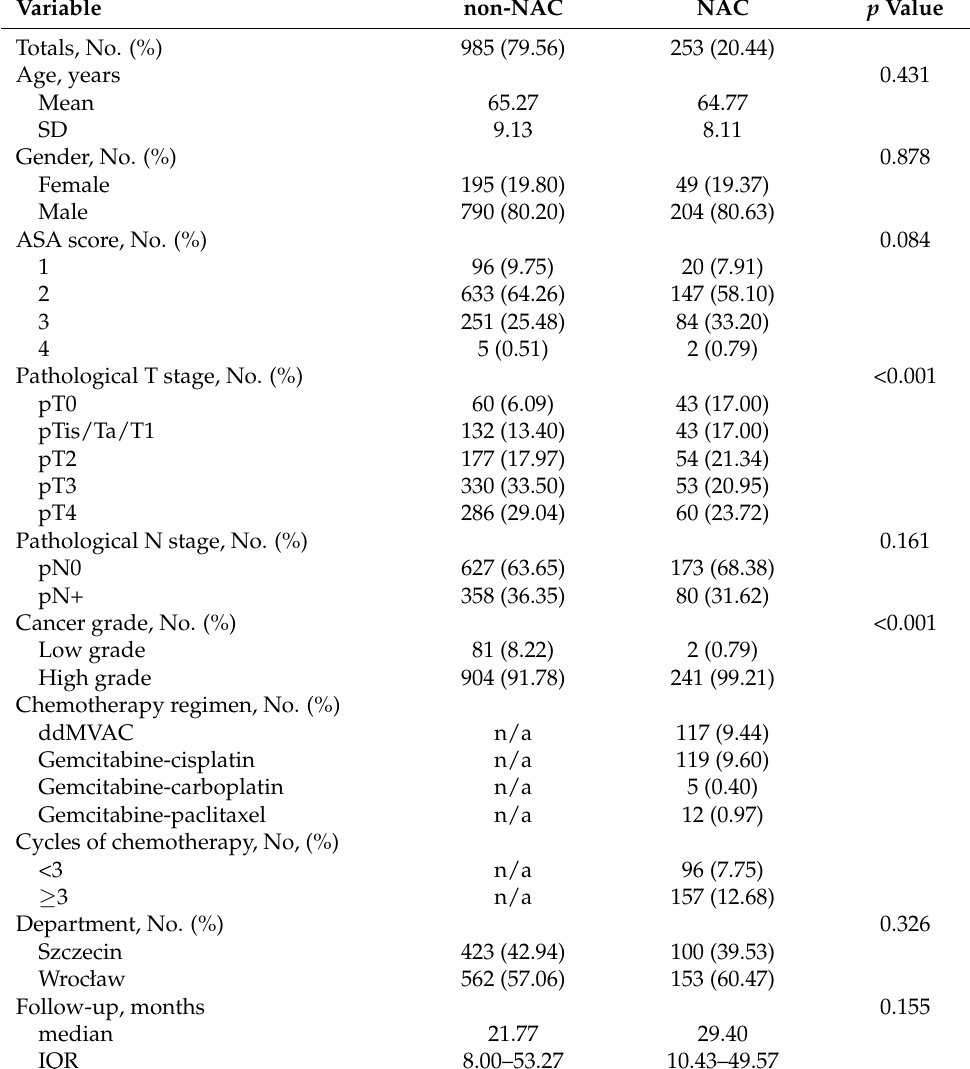
Table 2. Baseline patients’ characteristics according to expose to neoadjuvant